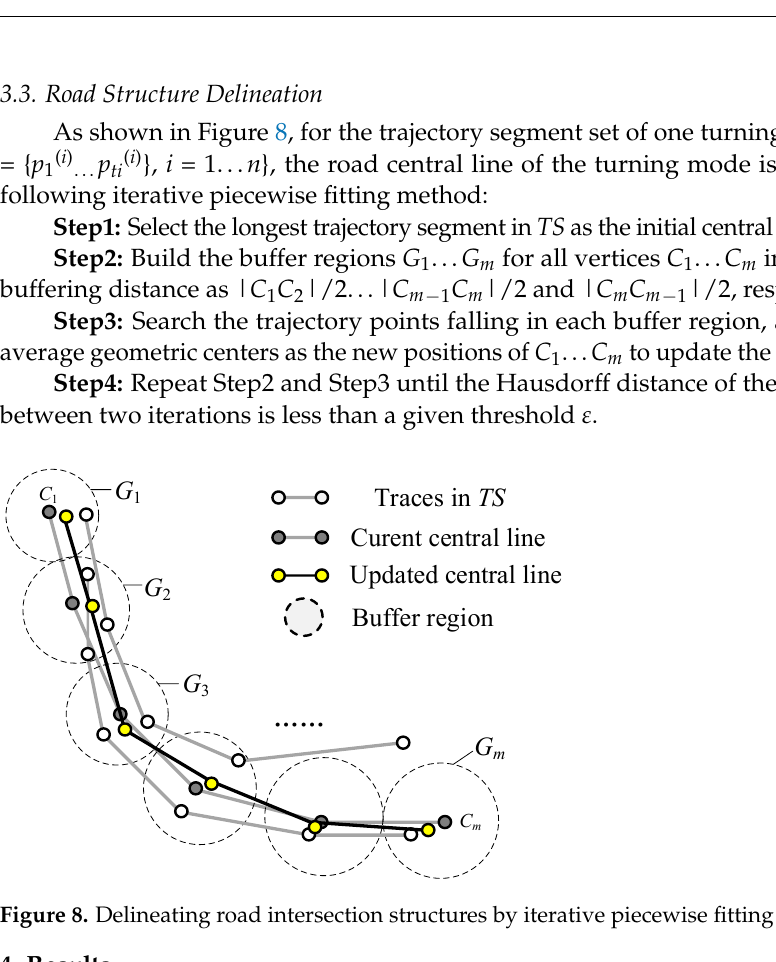
Figur e 7. Turning-modes segmentation based on heading code matrix of starting and ending points: ( a ) the heading code matrix of starting and ending points and ( b ) the trajectory segments of typical turning modes.